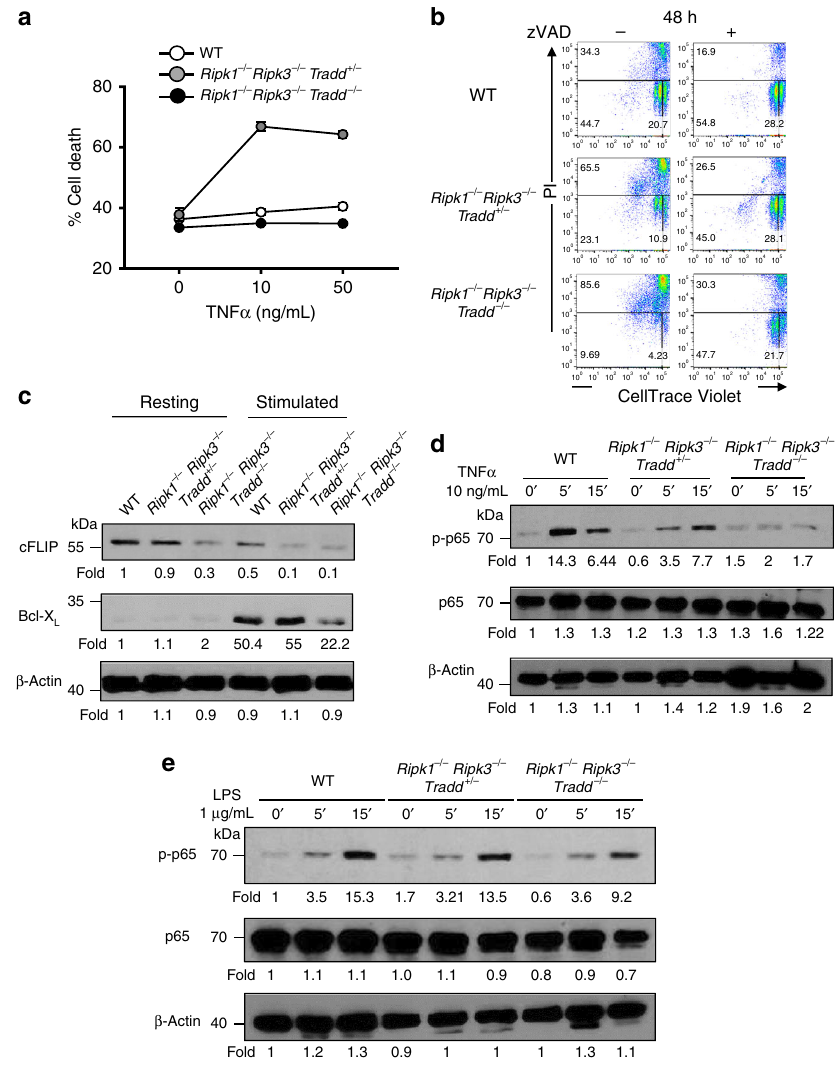
Fig. 4 Cell death and survival of Ripk1 − / − Ripk3 − / − Tradd + / − and Ripk1 − / − Ripk3 − / − Tradd − / − cells. a Thymocytes were treated with indicated concentrations of TNF α for 16 h with 30 μ g/mL cycloheximide. After addition of 1 μ g/mL propidium iodide (PI), dead cells (PI + ) were determined by fl ow cytometry (performed in triplicate, presented as mean ± SEM, n = 3 independent experiments). b Mature T cells were isolated from the lymph nodes and spleen, labeled with CellTrace Violet (Invitrogen), pretreated for 1 h with or without 50 μ M zVAD-fmk, and stimulated with 5 μ g/mL α CD3 and 1 μ g/mL α CD28. At 48 h, cells were harvested, stained with PI, and analyzed by two-color fl ow cytometry ( n = 3 independent experiments). c Western blot of cFLIP, Bcl-X L , and β -Actin in resting and stimulated mature T cells of indicated genotypes. Representative of three independent experiments. d , e Western blots of p65 phosphorylation, total p65, and β -Actin after stimulation of fi broblasts with d 10 ng/mL TNF α ( n = 5 independent experiments) or e 1 μ g/mL LPS ( n = 3 independent experiments). Numbers under each gel indicate fold changes of signals for each lane It is possible that the loss of DP thymocytes in Ripk1 − / − Ripk3 − / − Tradd − / − (Fig. 3a) is secondary to the wasting disease (Fig. 1c). To this end, we analyzed younger mice (3 week old) which have no apparent wasting disease. The lymphoid organs of mouse fi broblasts. In WT fi broblasts rapid phosphorylation of young Ripk1 − / − Ripk3 − / − Tradd − / − mice are normal, as com- p65 was induced within 5 min of TNF α treatment, but NF κ B pared to WT controls (Supplementary Fig. 9a). There was no activation is completely blocked in Ripk1 − / − Ripk3 − / − Tradd − / − fi broblasts (Fig. 4d). A single allele of TRADD in Ripk1 − / − obvious defect in the thymus, and mature T cell numbers in Ripk3 − / − Tradd + / − fi broblasts results in an intermediate pheno- lymph nodes was reduced in Ripk1 − / − Ripk3 − / − Tradd − / − mice type, that is a delayed activation of the NF κ B pathway (Fig. 4d). (Supplementary Fig. 9b, c). Thymocytes isolated from 3 week old Ripk1 − / − Ripk3 − / − Tradd − / − mice are also resistant to TNF α - We treated wild-type and mutant fi broblasts with LPS and ana- lyzed NF κ B induction. Ripk1 − / − Ripk3 − / − Tradd − / − fi broblasts induced cell death unlike Ripk1 − / − Ripk3 − / − Tradd + / − thymo- were capable of phosphorylating NF κ B, albeit at slightly lower cytes (Supplementary Fig. 10), similar to the result in Fig. 4a. We levels than WT fi broblasts (Fig. 4e). In total, TRADD is essential performed analysis of NF κ B target genes in TNF α -treated fi broblasts, and the data indicates impaired NF κ B signaling in for TNF α -induced NF κ B activation in Ripk1 − / − Ripk3 − / − fi bro- blasts, but is dispensable for LPS-induced NF κ B activation. TKO cells. TNFAIP3 (or A20), an NF κ B target gene, is NATURE COMMUNICATIONS| (2019) 10:705